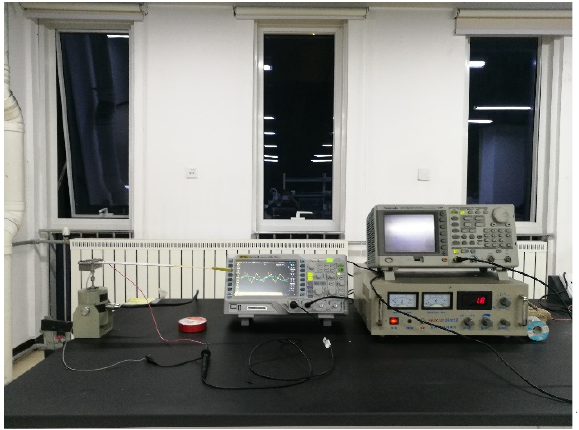
Figure 20. The test of triangular PCB.